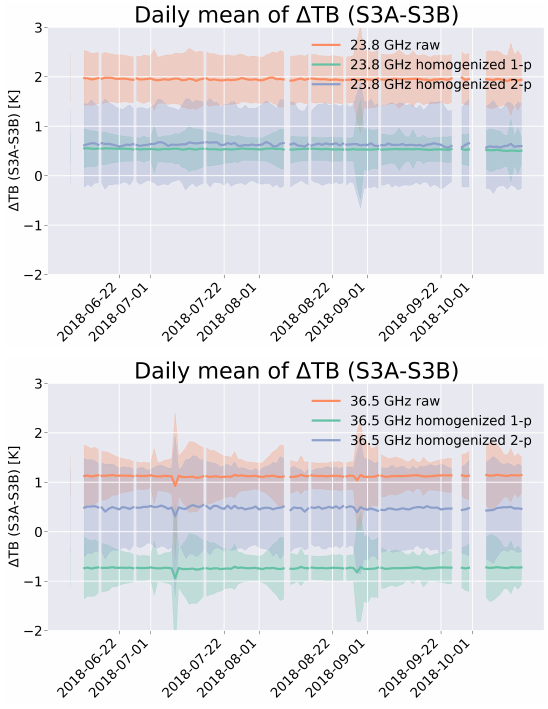
Figure 4. Monitoring of the bias between S3-A and S3-B T B during the tandem phase, for the 23.8 GHz channel ( top ) and the 36.5 GHz channel ( bottom ). The solid lines refer to the daily mean and the shaded area to the standard deviation of the difference. The orange features refer to the baseline T B , the green one to the homogenized h-1p T B and the blue one to the homogenized h-2p T B .